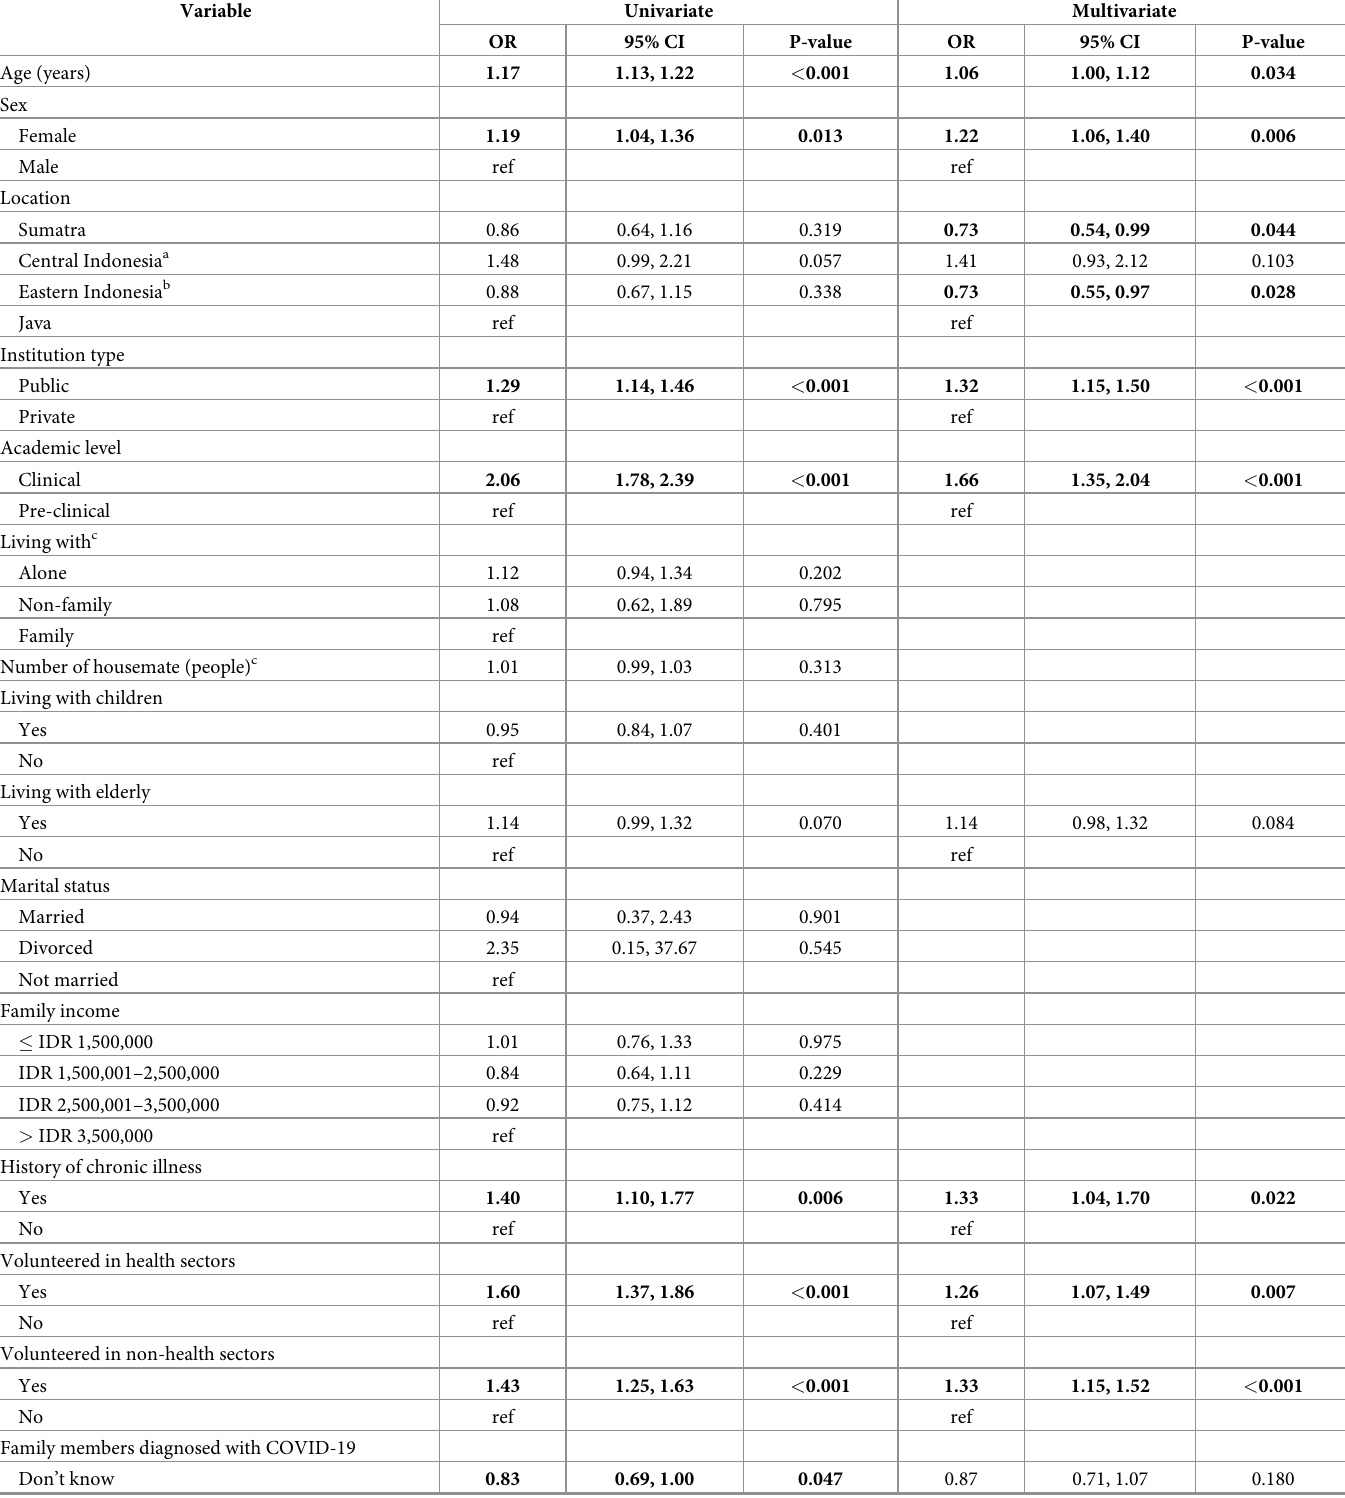
Table 1. Factors associated with knowledge on COVID-19 in the study population (n =